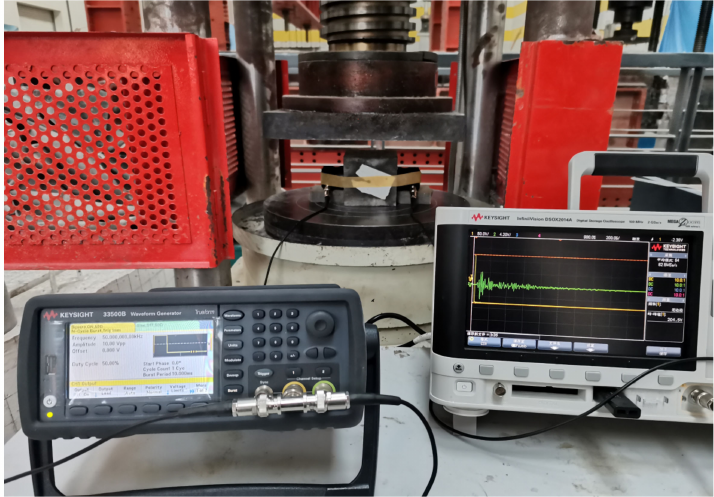
Figure 4. Ultrasonic coda wave test process under uniaxial